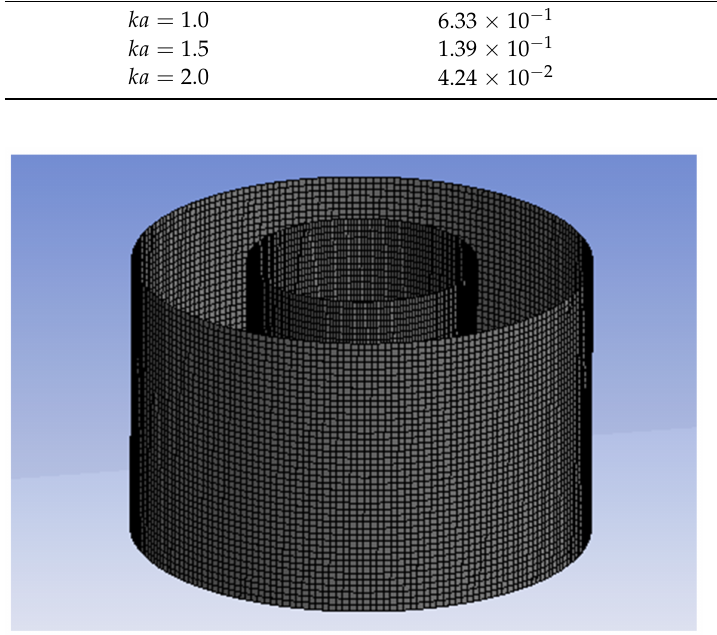
Figure 8. Mesh generation for the OWC